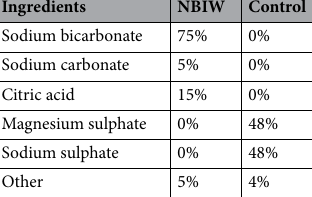
Table 1. Ingredients of the bath tablets. NBIW neutral bicarbonate ionized